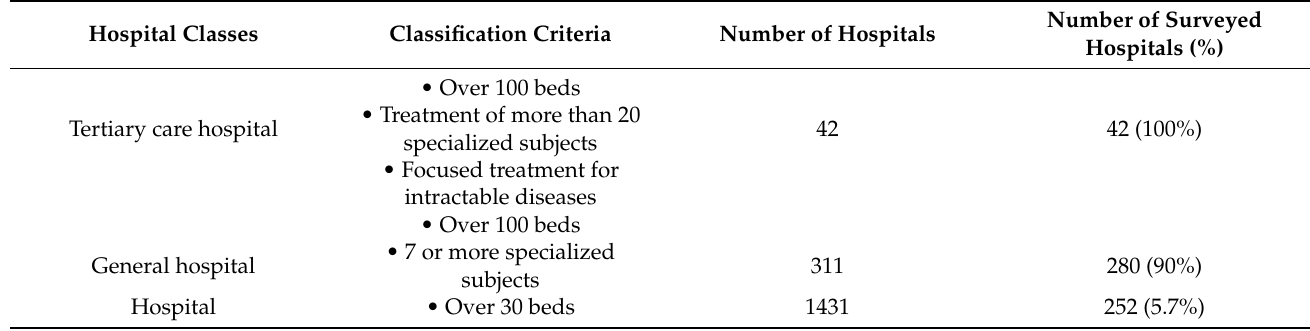
Table 2. Survey target hospitals and hospital classification in